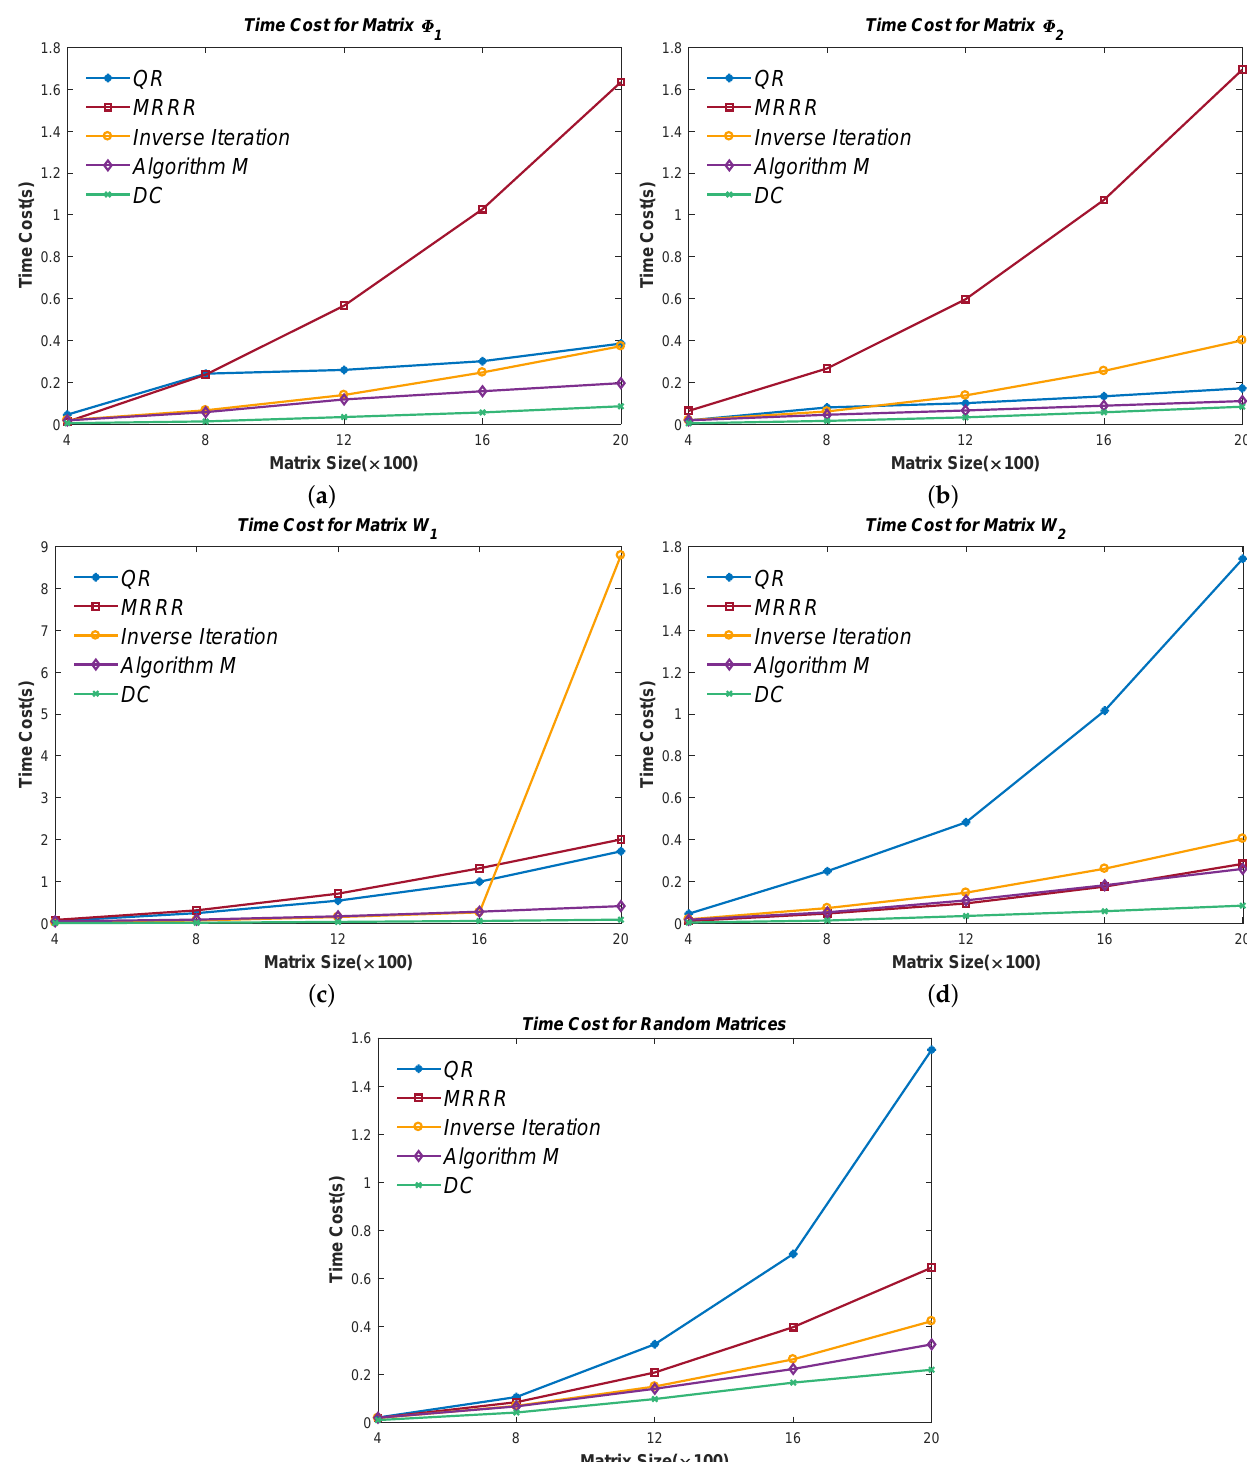
Figure 17. The time cost for all eigenpairs in: ( a ) Matrix Φ 1 ; ( b ) Matrix Φ 2 ; ( c ) Matrix W 1 ; ( d ) Matrix W 2 ; ( e ) Random